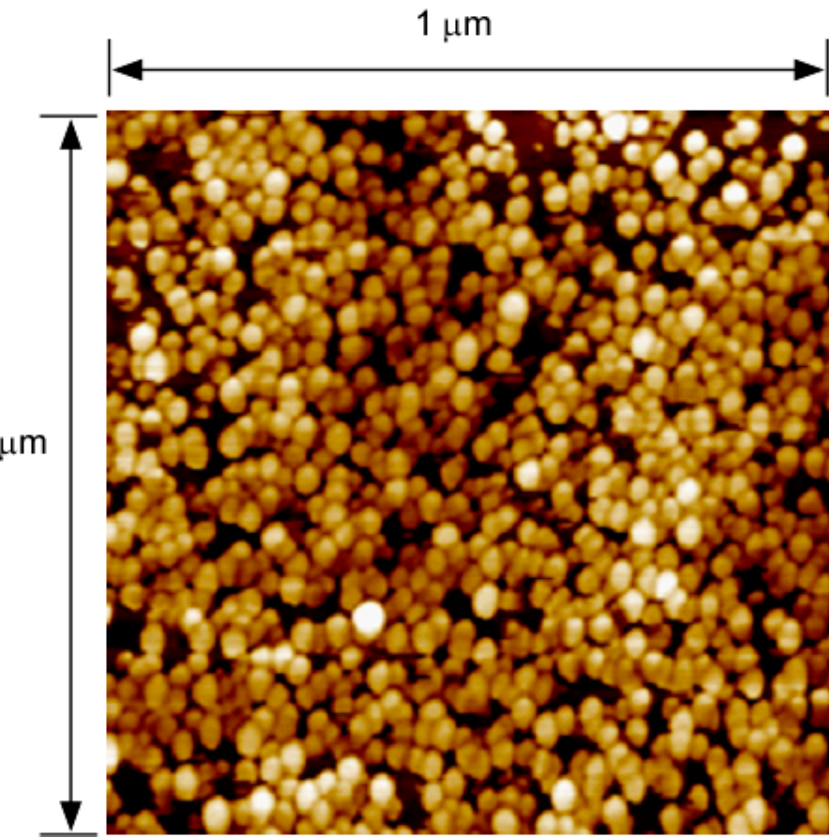
Figure 2. Atomic force microscopy (AFM) image of the QDs grown at the same growth conditions as the photodetector device. The SML QDs are uniform with a high density of ~ 4 × 10 10 /layer.